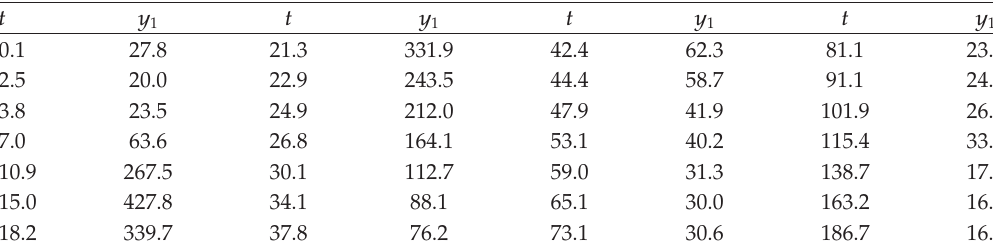
Table 1: Data of Case 1 (cid:3) An enzyme e ff usion problem (cid:4)